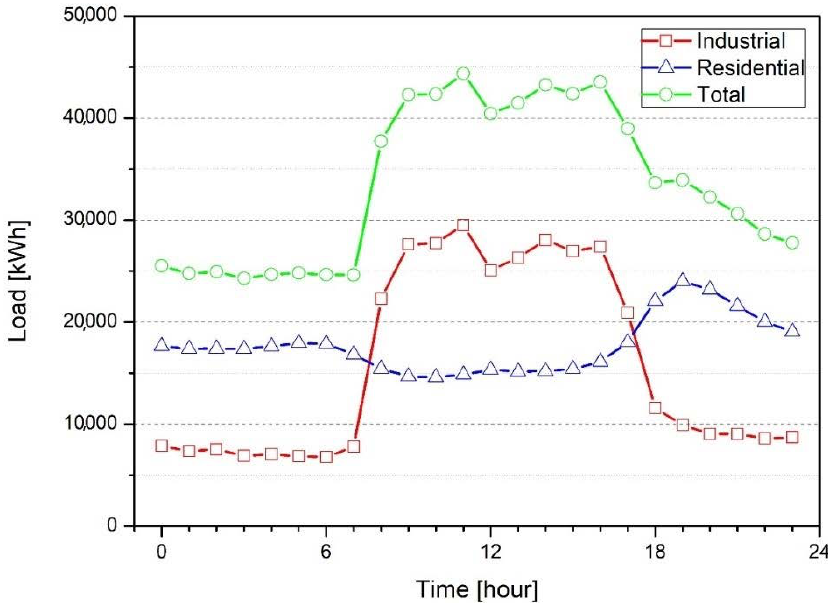
Figure 3. Hourly power load of the residential and industrial complexes in a year (cumulative amount).